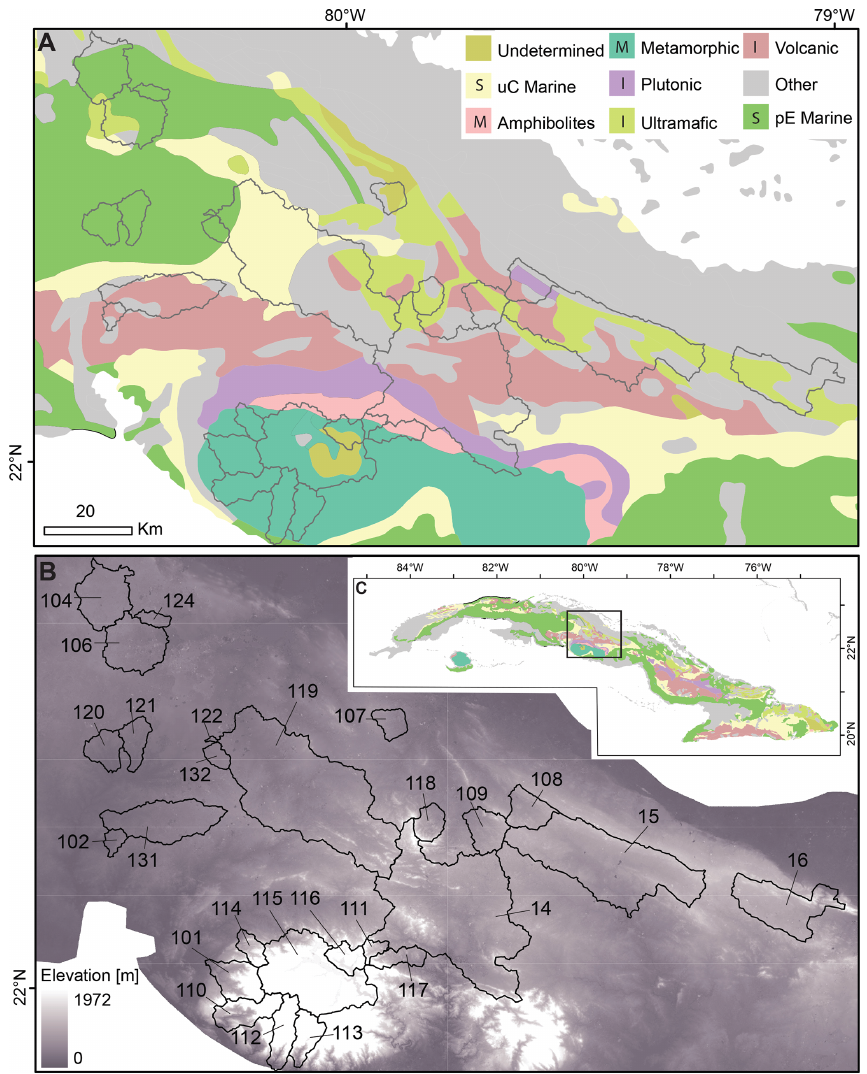
Figure 2. Maps showing underlying the basin geology ( a ; French and Schenk, 2004), elevations ( b ; LP DAAC, 2022), and location of the study area within the island of Cuba (c) . The legend for panel (a) includes the category of the rock units in terms of sedimentary (S), igneous (I), and metamorphic (M). Note that the two marine units in panel (a) are separated because they have different river water